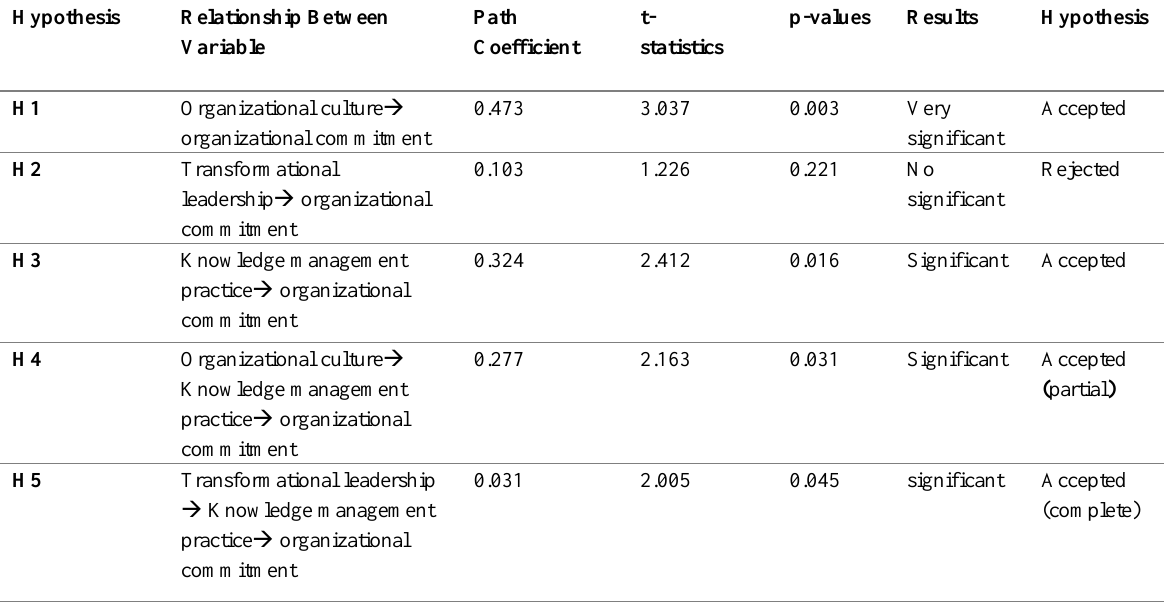
Table 2 : Hypothesis Testing